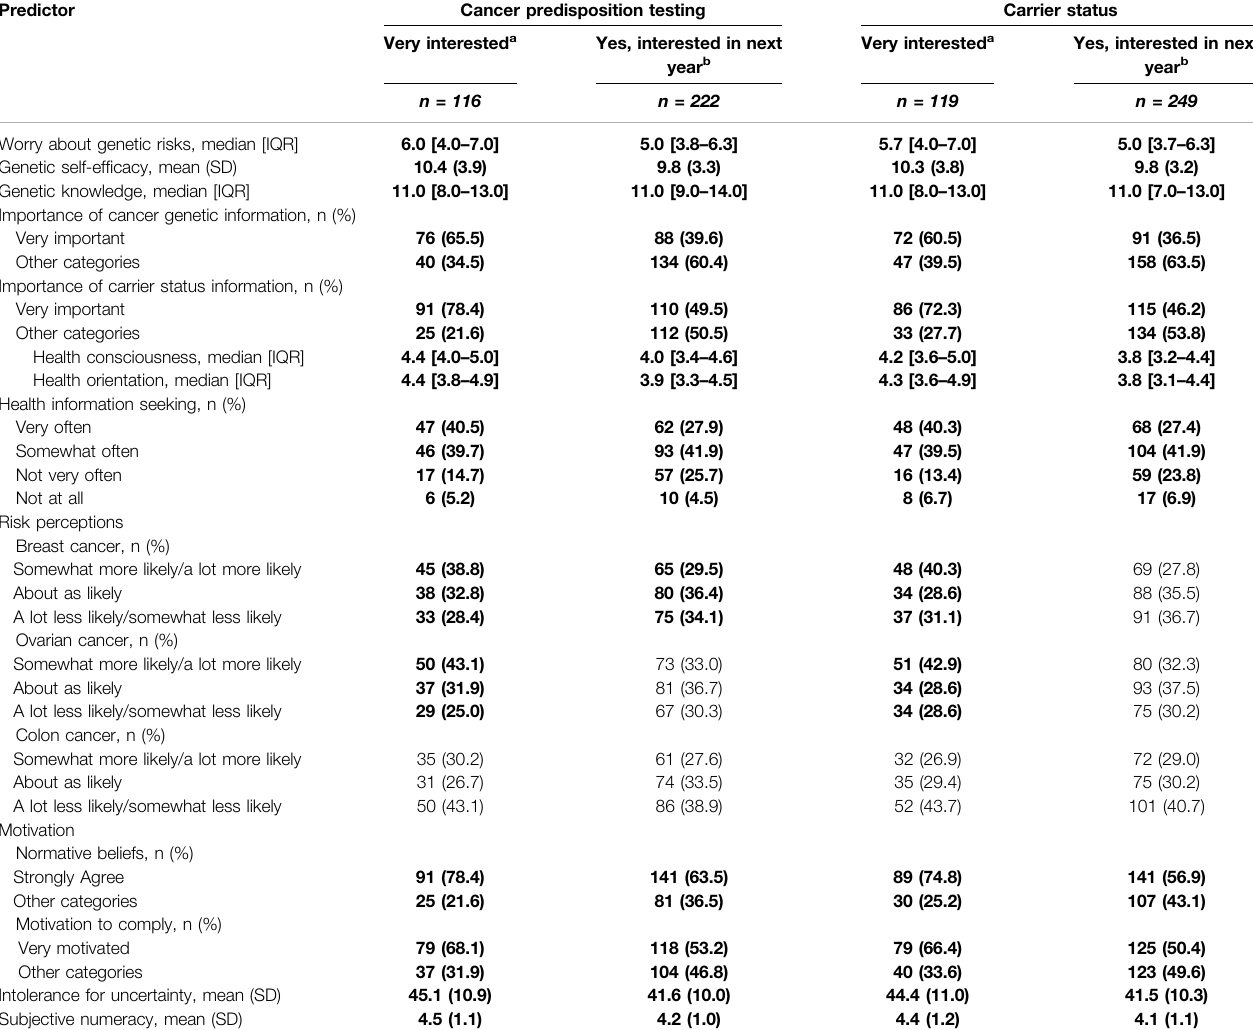
TABLE 5 | Bivariate predictors of interest in receiving cancer predisposition testing and carrier screening ( n = 450).